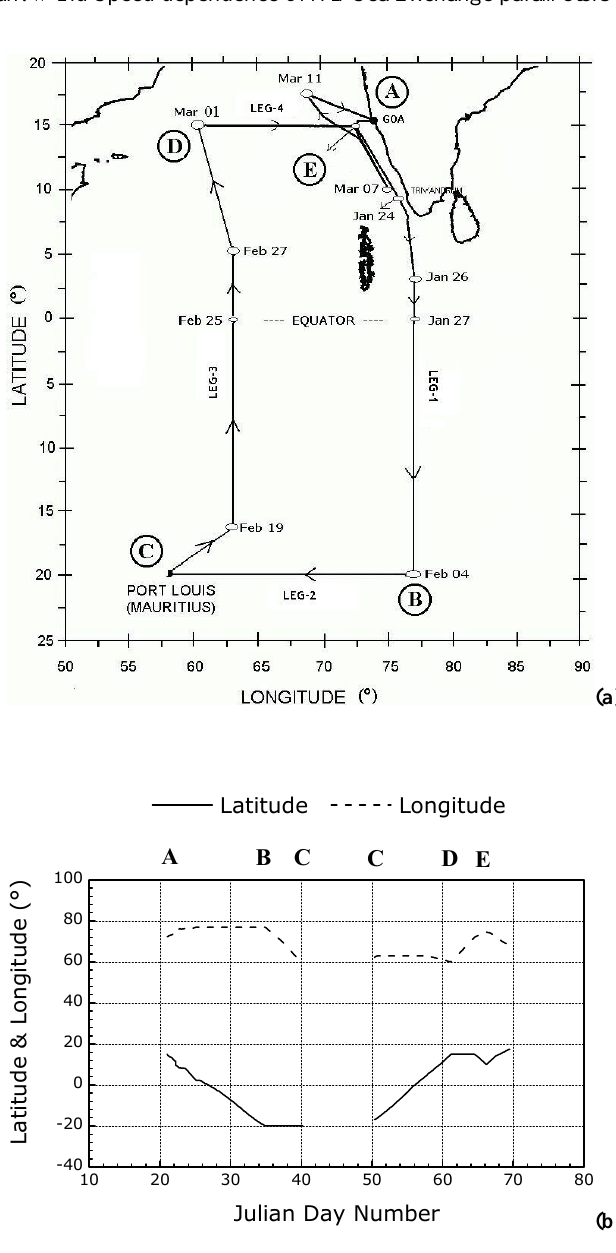
Fig. 1. (a) Cruise track of the field experiment “INDOEX, IFP- 99” conducted on board ORV Sagar Kanya during 20 January – 12 March1999. (b) Position of ship in terms of geographic latitude and longitude with Julian day